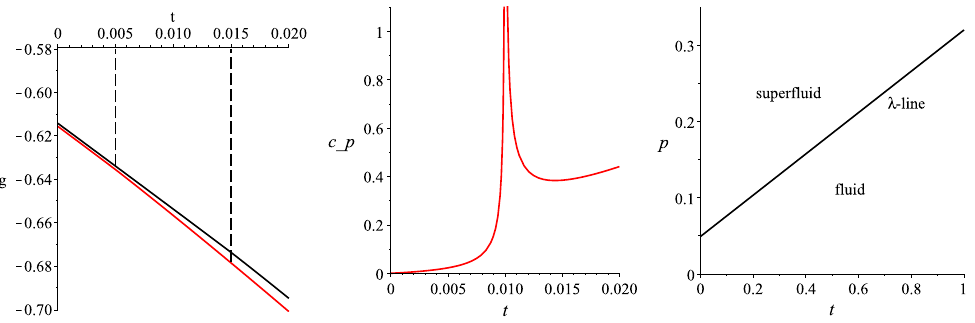
Figure 8 . Black hole (cid:21) -line: Left : a plot of the gibbs free energy for two di(cid:11)erent values of pressure corresponding to t c = 0 : 005 and 0 : 015 as indicated by the vertical, dashed lines. At these points, the Gibbs free energy has a cusp, indicating a diverging speci(cid:12)c heat. Center : a plot of the speci(cid:12)c heat for the case where the second order phase transition occurs at t c = 0 : 01, the shape is characteristic of the (cid:21) -line. Right : a plot of the phase diagram. The solid black line is the (cid:21) -line, which corresponds to a line of second order phase